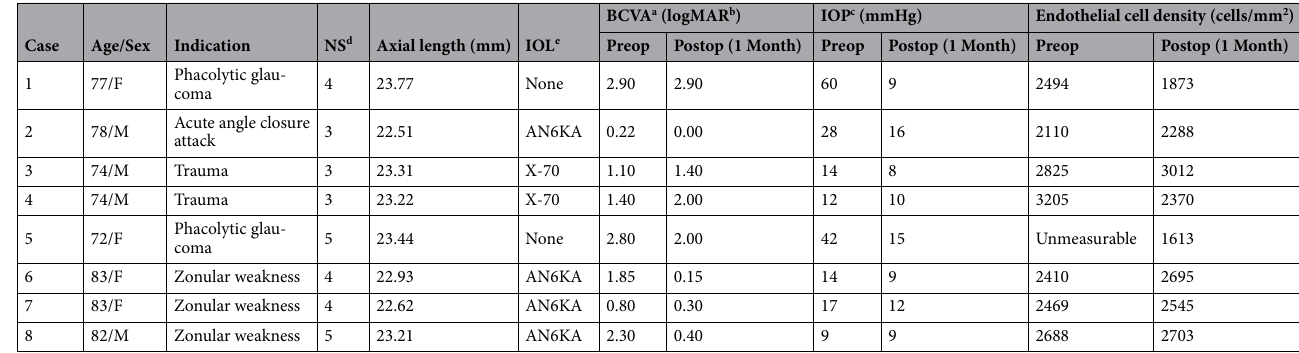
Table 2. Individual patient data. a BCVA: best-corrected visual acuity. b logMAR: logarithm of the